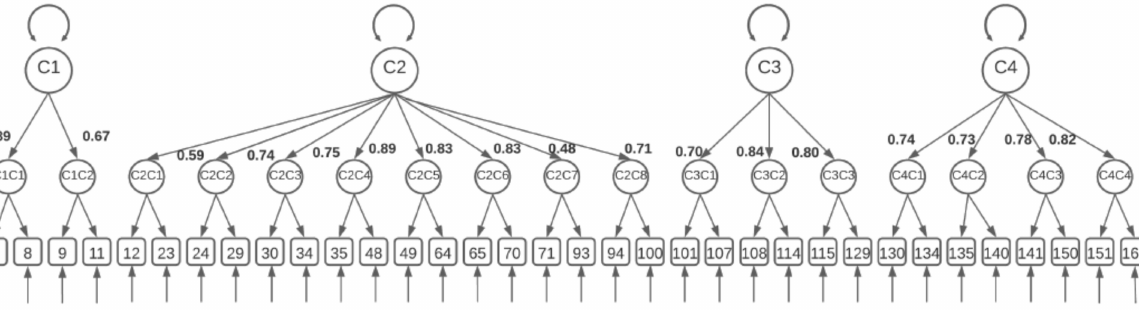
Figure 2. This is a figure of the confirmatory factor analysis: C1: ethical and legal practice; C2: